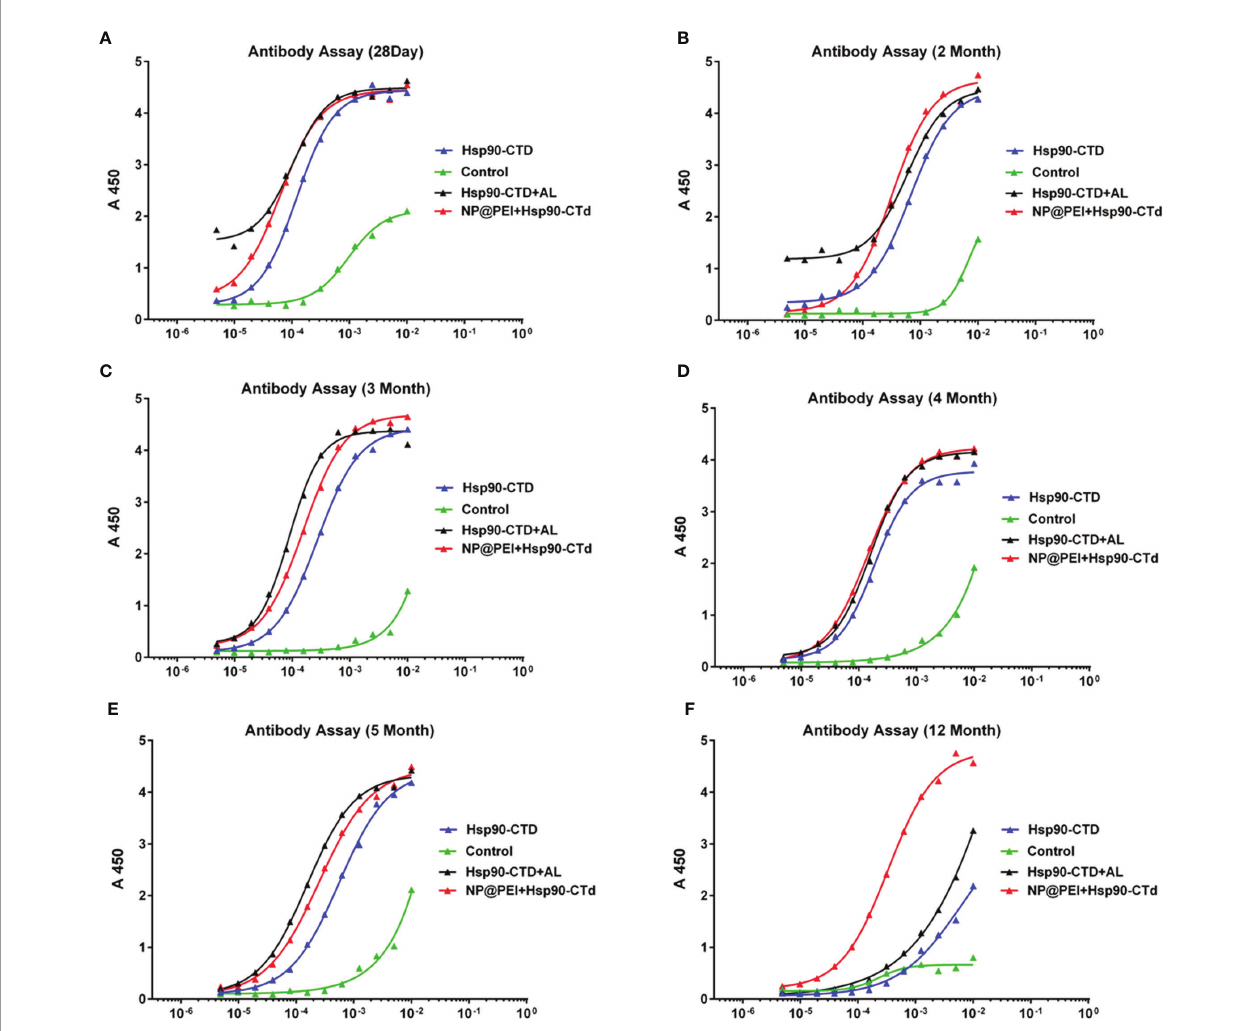
FIGURE 5 | Hsp90-CTD (1µg/ml) was coated into 96-well ELISA plates at 4°C overnight. Blood from 4 groups (control, Hsp90-CTD, Hsp90-CTD+AL, and NP) of mice was collected at different time points, 3 mice/group. Sera were obtained after centrifugation at 9000 rpm for 10 min. The sera were diluted 500 times and the antibody levels were then measured by ELISA. (A) 28 days. (B) 2 months. (C) 3 months. (D) 4 months. (E) 5 months. (F) 12